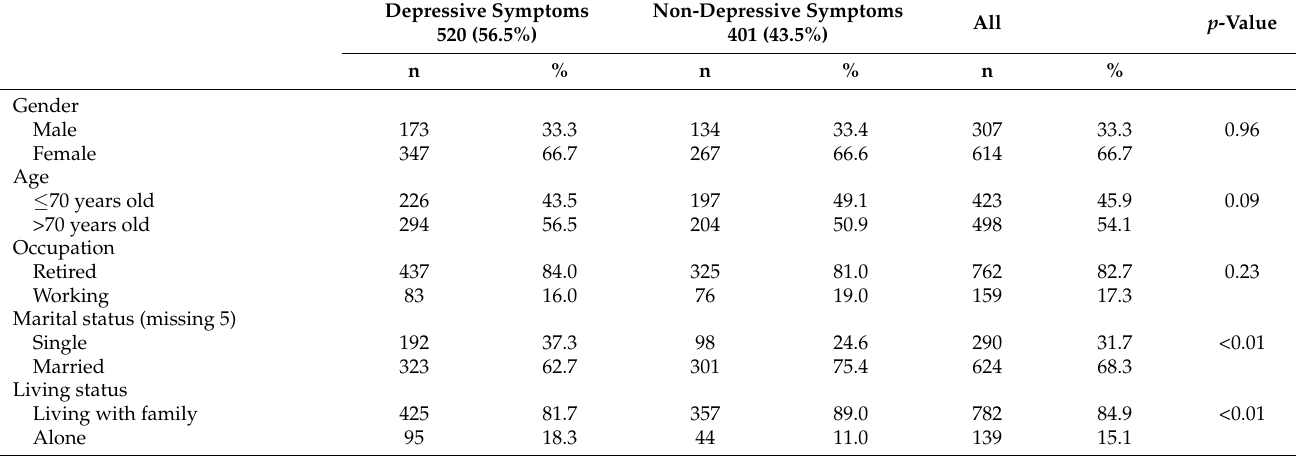
Table 1. Demographic characteristics of respondents by depressive